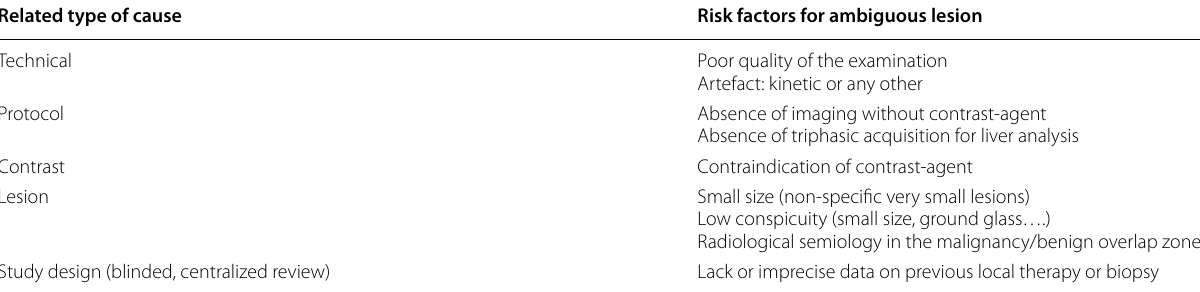
Table 2 Causal factors of equivocal lesions during the oncologic assessment Related type of cause